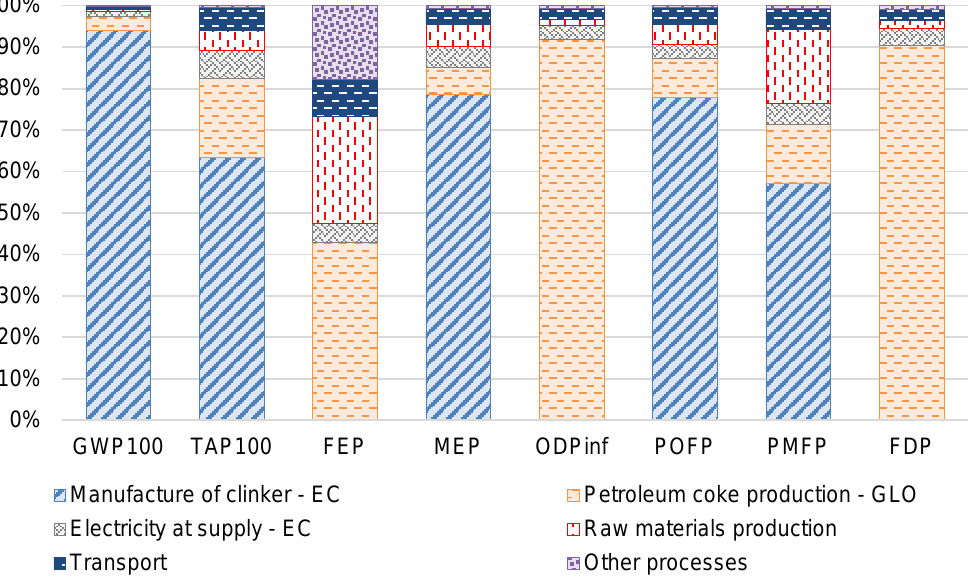
Figure 2. Contribution analysis for each environmental impact category for processes per ton of clinker (functional unit). GWP100: global warming potential; TAP100: terrestrial acidification potential; FEP: freshwater eutrophication potential; MEP: marine eutrophication potential; ODPinf: ozone depletion potential; POFP: photochemical oxidant formation potential; PMFP: particulate matter formation potential; FDP: fossil depletion potential; EC: Ecuador; and GLO: global. Nitrogen oxides (NO x ), sulfur dioxide (SO 2 ), and ammonia (NH 3 ) are the main emis- sions contributing to TAP100, which are present in the flue gases from clinker kilns. This process contributes 0.964 kg SO 2 -Eq/ton of clinker, corresponding to 63.5% of the indicator. The production of petroleum coke contributes 0.29 kg SO 2 -Eq/ton of clinker, representing 19.25% of this category; the result is 1.52 kg SO 2 -Eq/ton of clinker. Çankaya & Pekey [40] obtained results of terrestrial acid/nutri in 8.41 SO 2 -Eq/ton of clinker for a traditional sce- nario, and 6.75 SO 2 -Eq/ton of clinker for an alternative scenario, clinkerization contributes 75%, raw materials, 13%; and electricity, 6.5%. Most of the difference between Çankaya & Pekey [40] and this study is due to the composition of fossil fuels (such as petroleum coke, lignite, fuel oil, and natural gas) and the use of alternative fuels. The results of FEP for this study are lower than Garc í a-Gusano et al. [41], with 0.42 × 10 − 2 kg and 1.21 × 10 − 2 P-Eq/ton of clinker, respectively. Figure 2 shows that the process with the greatest contribution is the manufacture of petroleum coke, with 43.04%, and electricity, 4.55% of the total FEP. Garc í a-Gusano et al. [41] found that the fossil fuel combustion and electricity consumed entail 40% and 37%, respectively. These differences are mostly due to the electricity mix and the efficiency of electrical consumption; this study has 71.24 kWh/t of clinker, and the Spanish industry has 92 kWh/t of clinker in 2010. Regarding MEP, the result obtained for Ecuador is 0.08 kg N-Eq/ton of clinker. The clinker production process contributes 78.6% to the MEP results due to the NO x emitted during